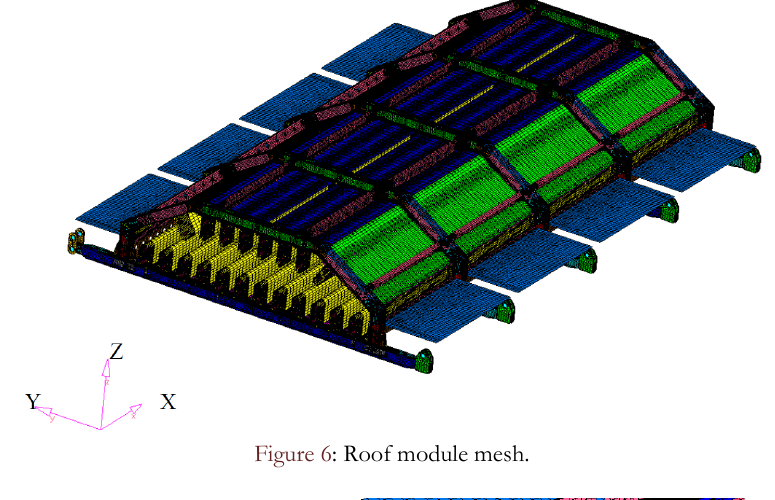
Figure 6: Roof module mesh.